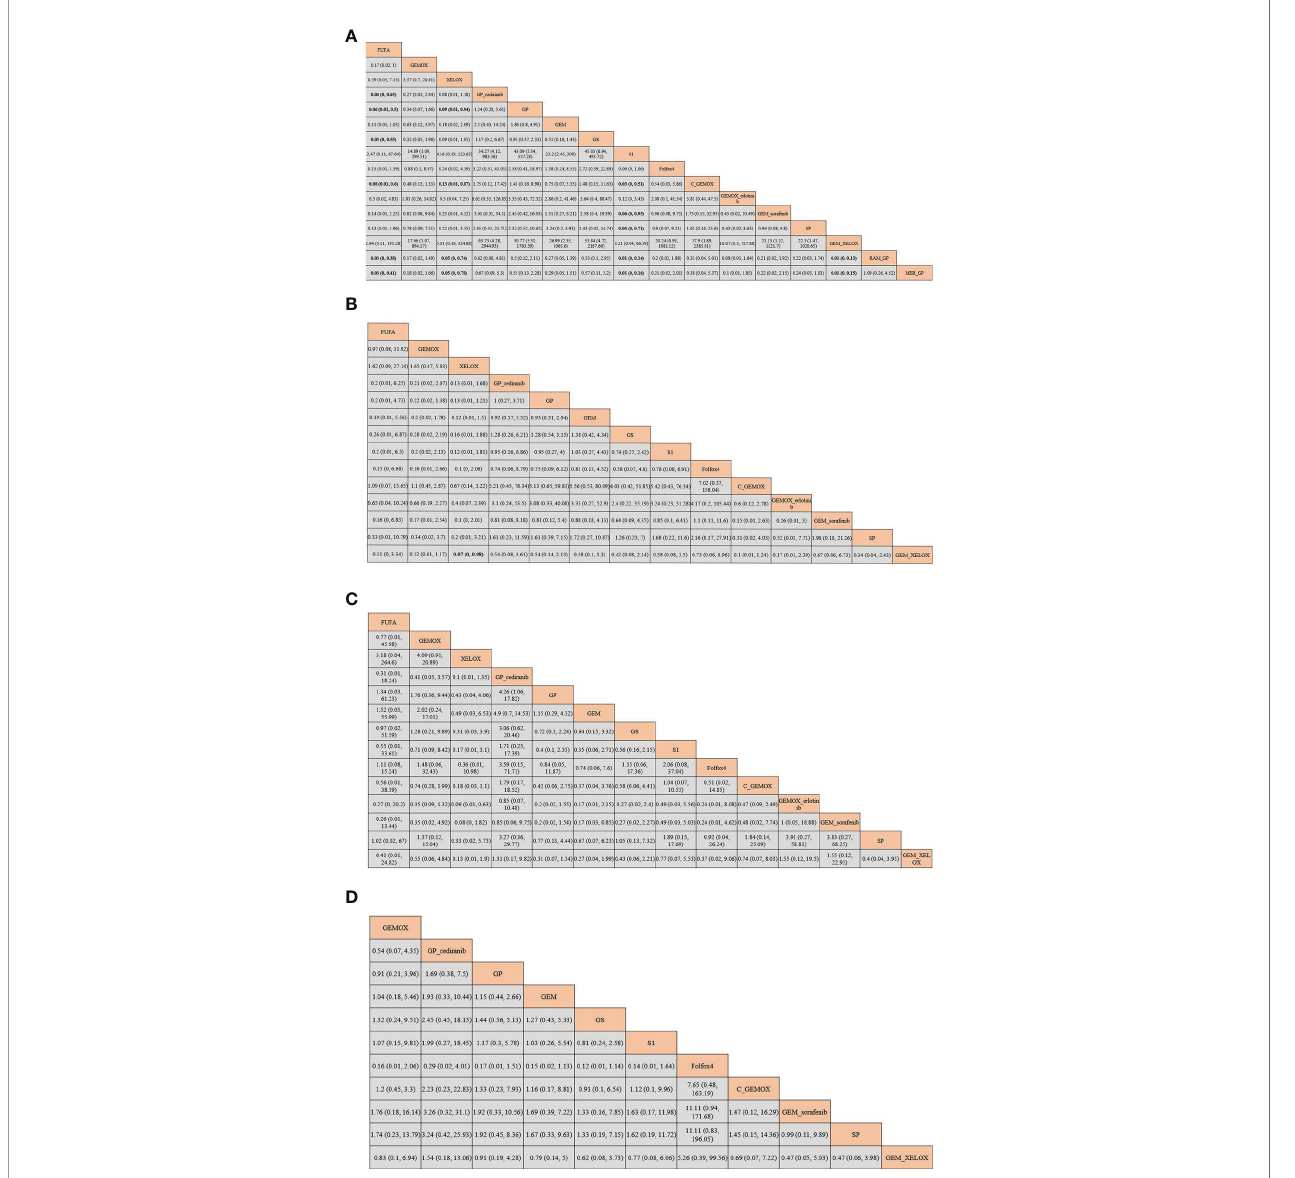
FIGURE 7 | Bayesian network meta-analysis (NMA) results of adverse events (AEs) of each protocol: (A) neutropenia; (B) vomiting; (C) diarrhea; (D)